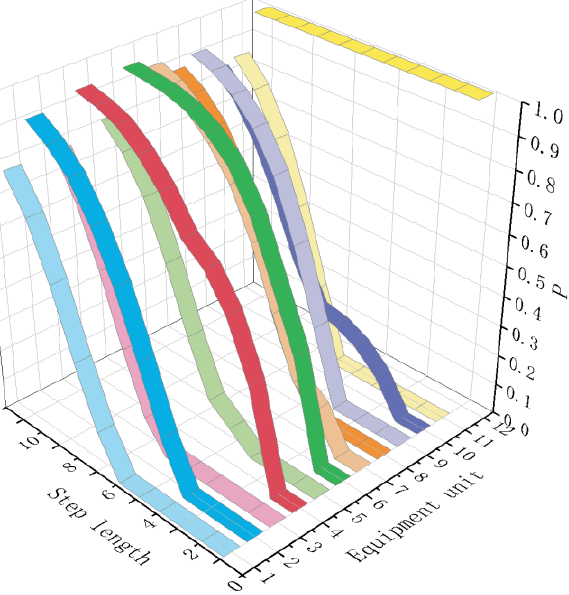
Figure 9. The fire probability of the equipment in the engine room changes at each time step when E12 is the initial fire source.